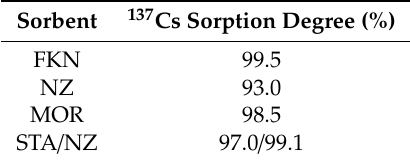
Table 2. The results of 137 Cs sorption by various sorbents in the prepared S-HLW.